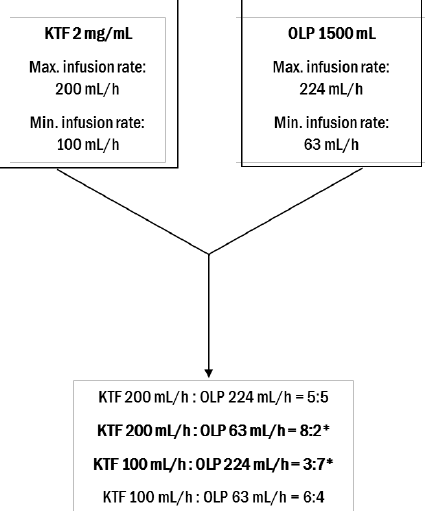
. Figure 1. Calculation of the KTF to PN admixtures ratios from the example of Olimel Peri N4E 1500 mL (* extreme KTF-PN ratios).